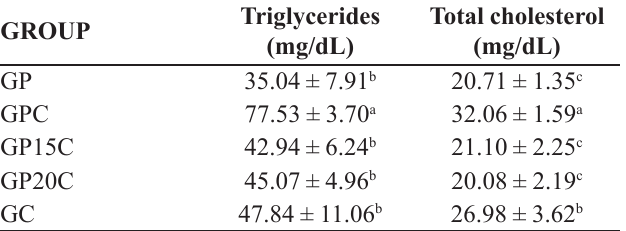
GP - diet with bread; GPC - diet with bread and cholesterol; GP15C - diet with 15% quinoa bread and cholesterol; GP20C - diet with 20% quinoa bread and cholesterol; GC - diet with cholesterol. Values in the same column with different letters indicate a statistically significant difference between the means by the Tukey test (p ≤ 0.05).